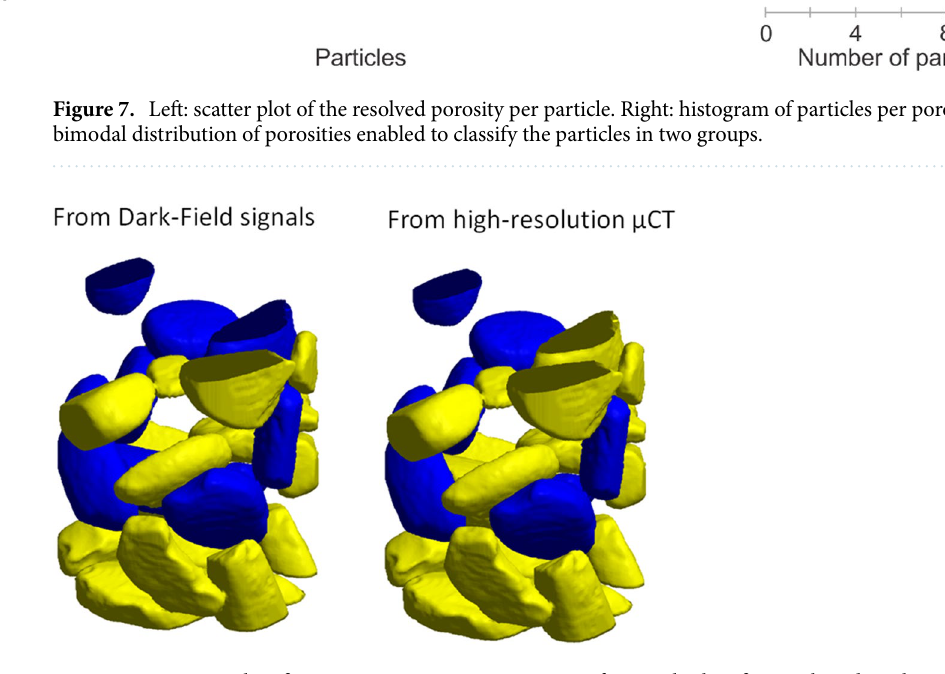
Figure 8. K-means classification consistency comparison. Left: particle classification based on the AFS value derived from dark-field acquisition. Right: classification based on segmentation of high-resolution μCT. Blue particles are dominated by 50 nm pores, yellow particles are dominated by 150 nm